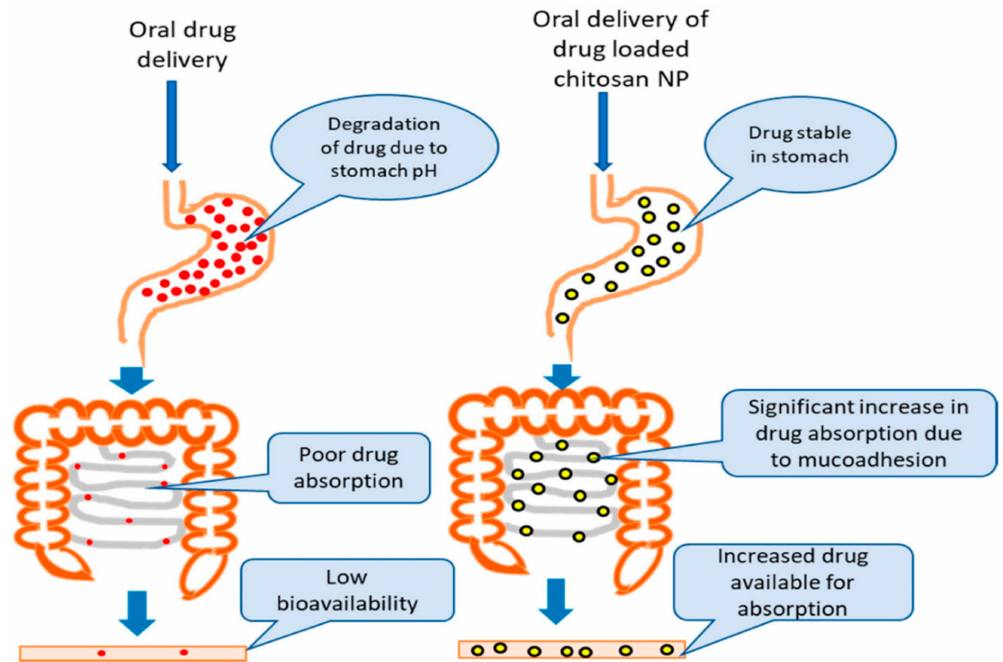
Figure 1. Chitosan improves drug oral bioavailability. In vivo comparison of oral bioavailability of a chitosan-based nanoparticle and pure drug to investigate the effect of chitosan-based nanoparticles on improving the drug availability for absorption via the intestinal epithelium. Adapted and modified with permission from [21]. Copyright (2019)